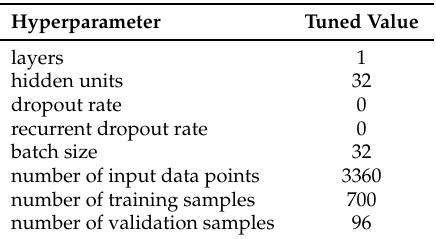
Table 2. Tuned hyperparameters for LSTRM RNN prediction model. BLEMtuneLSTM (